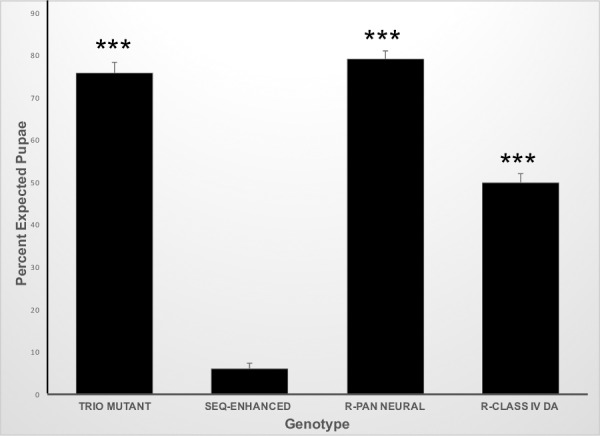
Tissue-specific expression of trio rescues pupation in the seq-enhanced trio mutant background.The percent of expected pupae was determined for the following genotypes: trio-mutant, trio-mutant background (trioM89
/ trioP1); seq-enhanced, seq-enhanced trio mutants (seq9.17
/ +; trioM89
/ trioP1); R-pan neural, rescue by pan-neural trio expression in the seq-enhanced trio mutant background (GAL4-elav.L / seq9.17; trioM89
/ trioP1, UAS-trio.B); R-class IV da, rescue by class IV da trio expression in the seq-enhanced trio mutant background (GAL4-ppk1.9, UAS-mCD8GFP / seq9.17; trioM89
/ trioP1, UAS-trio.B). N = 15 for all genotypes. ANOVA p-value <0.0001; *** indicates pair-wise statistical significance at p<0.001 as compared to *seq*-enhanced. R-pan neural and R-class IV da are also statistically different from each other at p<0.001. Error bars represent the standard error of the means.